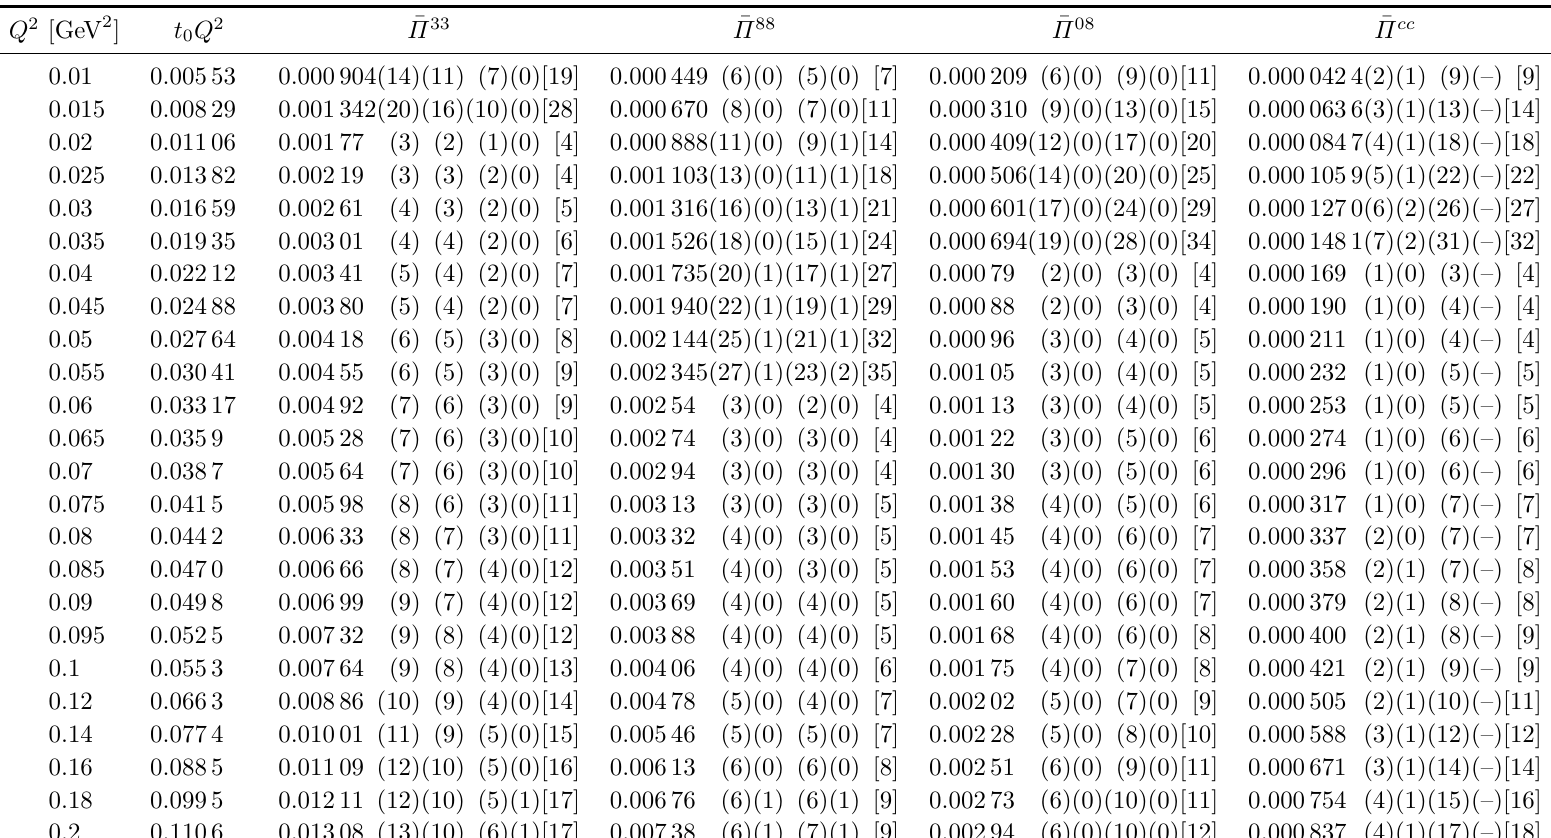
Table 12 . Results for the ¯ Π 33 , ¯ Π 88 , ¯ Π 08 and ¯ Π cc HVP contribution extrapolated to the physical point for all the values of Q 2 sampled. The first quoted uncertainty is the statistical error, the second is the systematic error from varying the fit model estimated in section 4.1.1, the third is the scale-setting error (see section 4.2.1), and the fourth is the systematic from missing charm sea-quark loops (see section 4.2.2). The final uncertainty, quoted in square brackets, is the combination of the previous ones